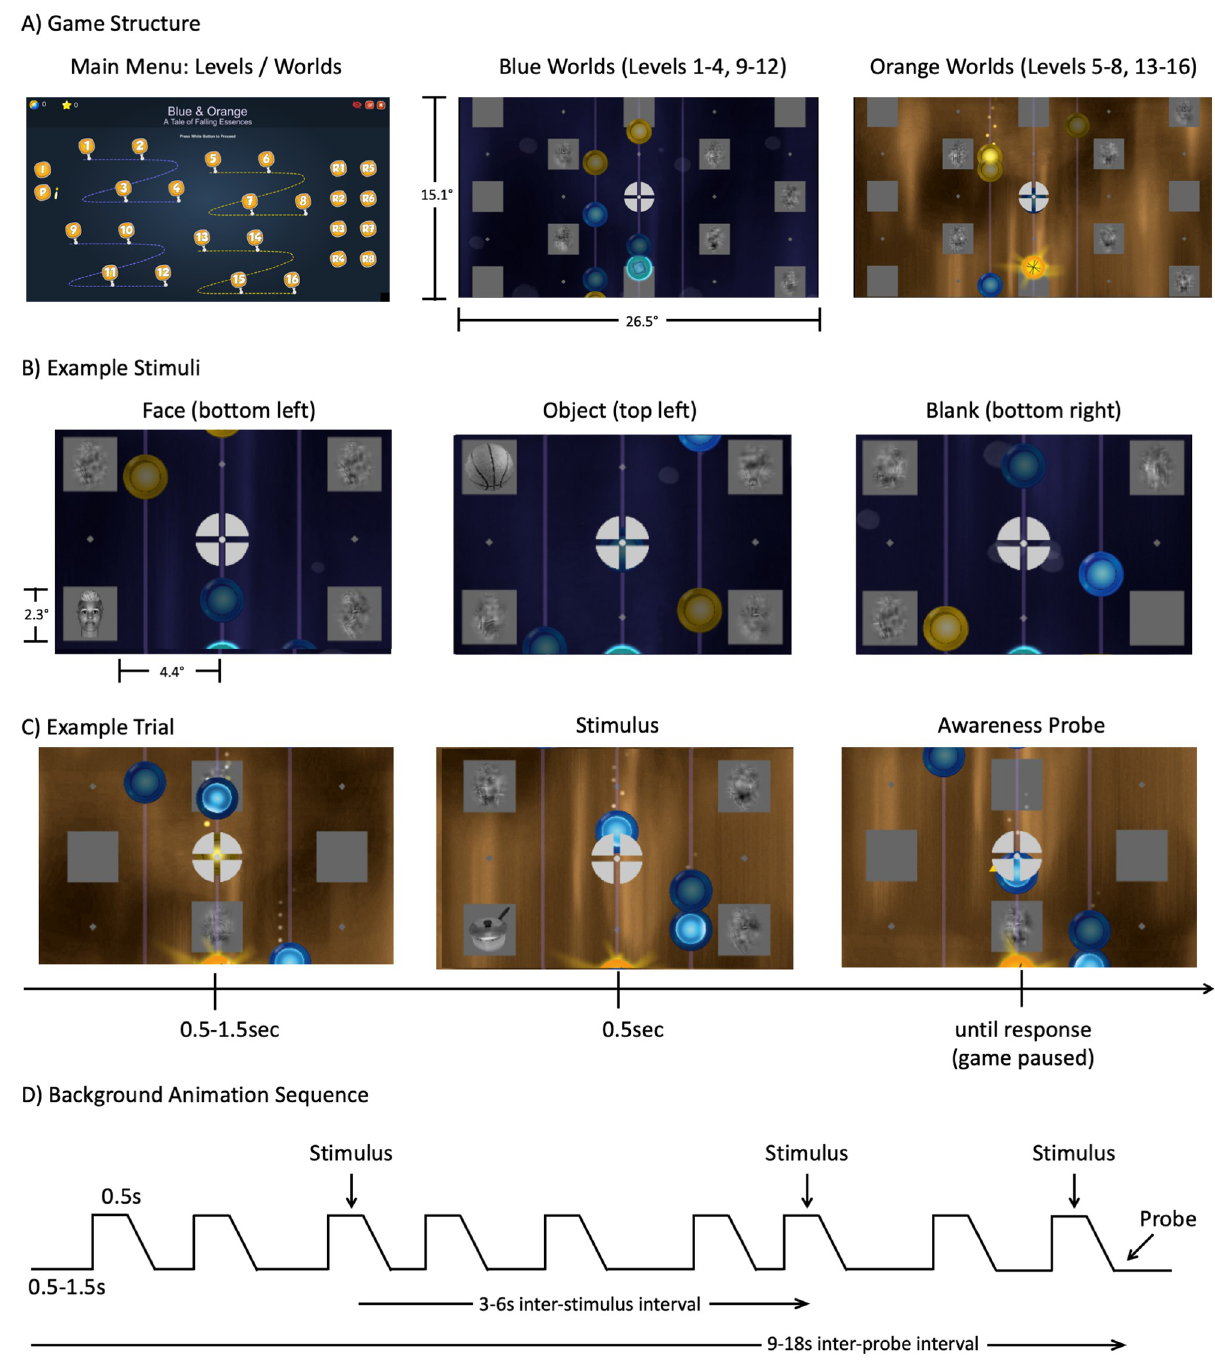
Fig 3. Experiment 2 design–A) The four worlds of the game, with four levels in each world (left). In worlds 1 & 3 (middle) the player will control a shiny blue orb at the bottom of the screen to collect falling disks of the same color (on three vertical tracks), while avoiding falling disks of a different color. The size of the full game display in visual angle is indicated here (panel A, middle). In worlds 2 & 4 the colors will be swapped and players will control an orange orb (right). B) Examples of stimuli presented in the background (central portion of screen blown-up for display purposes): face (left), object (middle), blank (right). C) During gameplay, at 3-6sec intervals (4-7sec for fMRI), an object/face/blank will appear on one of four background squares (middle) for 500ms total, 250ms at full contrast, followed by 250ms of fade-out. On some trials (every 9-18sec), the stimulus will be immediately followed by an awareness probe (right) in which the game will pause and a small arrow will appear in the center instructing subjects to report whether they had just noticed a stimulus in that location. D) Schematic of the background animation demonstrating the trial timing, stimulus timing, and probe timing. For a video demonstration of the video game, visit the preregistration website: https://osf.io/b9nce/).